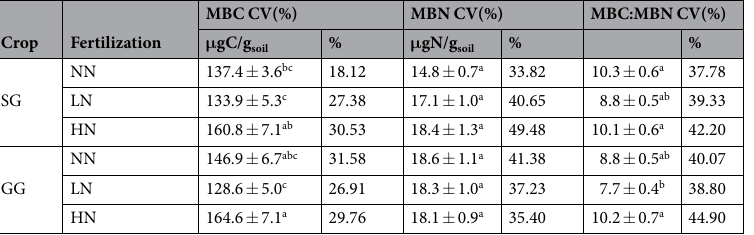
Table 1. Mean ( ± SE) microbial biomass carbon (MBC, µ gC/g soil ), microbial biomass nitrogen (MBN, µ gN/ g soil ) concentrations, MBC:MBN, and their respective coefficients of variance (CV, %) under three fertilization treatments (i.e. NN, LN and HN) in SG and GG cropland soils in a three-year long fertilization experimental site at the Tennessee State University (TSU) Agricultural Research Center in Nashville, TN, USA. SG: switchgrass; GG: gammagrass; NN: No nitrogen; LN: Low nitrogen (84 kg N/ha/yr); HN: High nitrogen (168 kg N ha/yr). Different lowercase letters within each column represent significant difference between nitrogen fertilization treatments at P < 0.05 (N = 48). The units for MBC and MBN are mgC/g soil and mgN/g soil in other Tables and all Figures, respectively (1 mg = 1000 µ g).